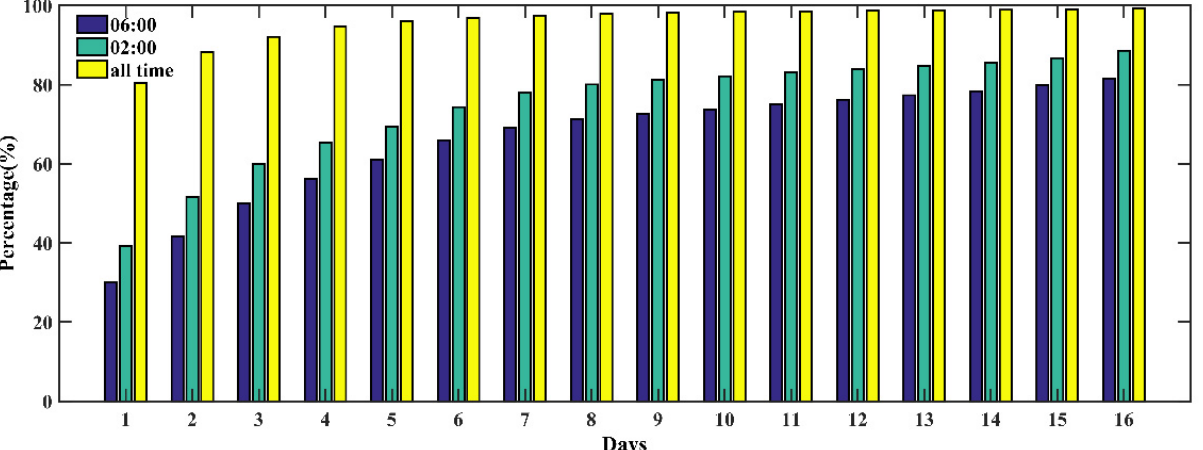
Figure 3. AHI observations over 16 days of compositing period. The color bars represent the percent of AHI clear pixels in our study domain, as defined in Figure 2.